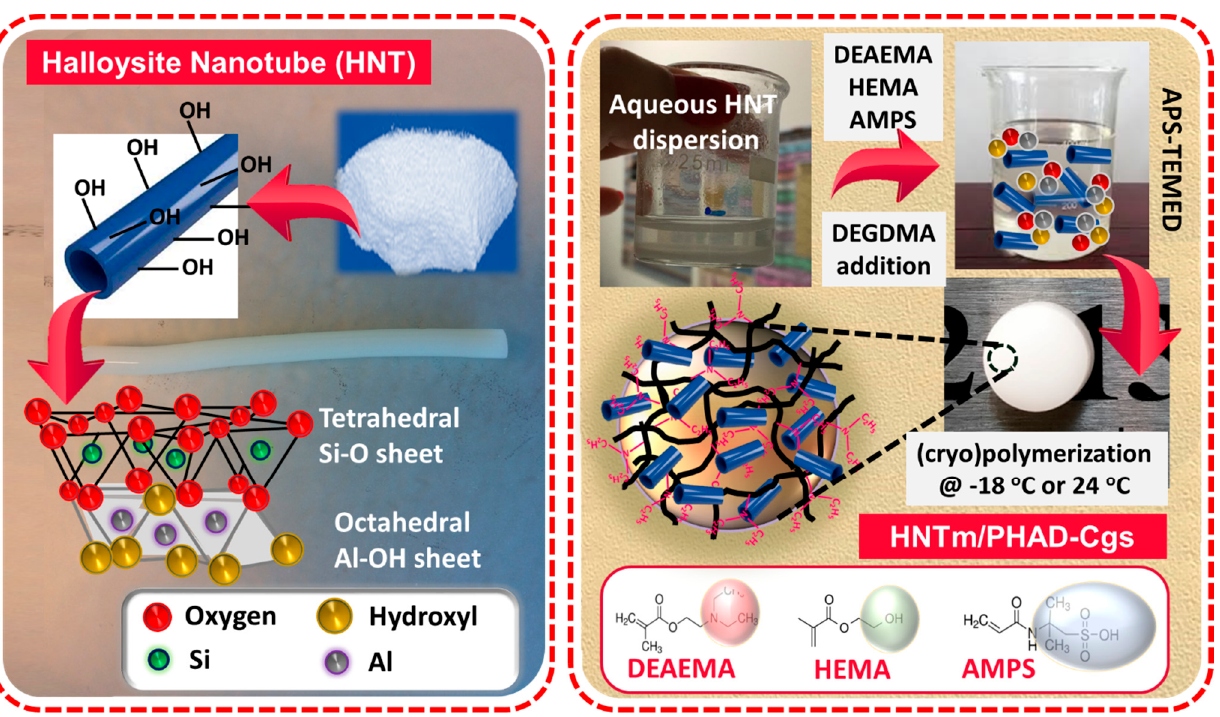
Scheme 1. Schematic diagram illustrating the structure and preparation process of ternary hybrid HNTm/PHADgels in the the presence of chemical crosslinker diethyleneglycol dimethacrylate (DEGDMA). presence of chemical crosslinker diethyleneglycol dimethacrylate